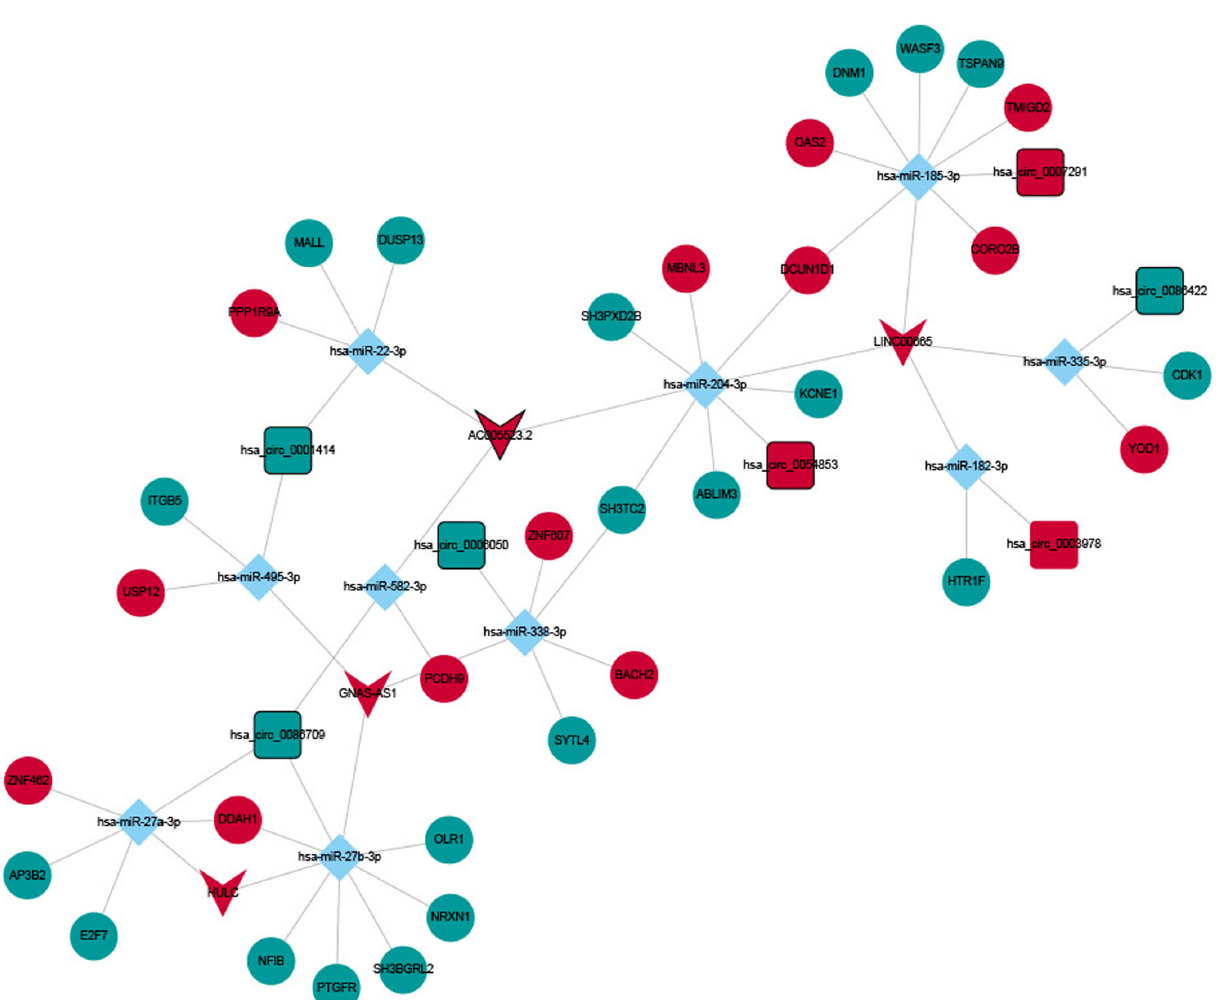
Figure 6. ceRNA (DEci rcRNA /DEln cRNA– miRNA –DEmR NA) regulatory network. The rectangles, inverted triangles, rhombuses, and ellipses indicate DEcircRNAs, DElncRNAs, miRNAs, and DEmRNAs, respectively. Red and blue colors represent upregulation and downregulation, respectively. Nodes with black border were DEcir cRNAs /DEln cRNAs /DEmR NAs derived from top 10 up- and downregulated DEcir cRNAs / DEln cRNAs /DEmR NAs. ceRNA, competing endogenous RNA; DEcircRNA, differentially expressed circular RNAs; DElncRNAs, differentially expressed long non-coding